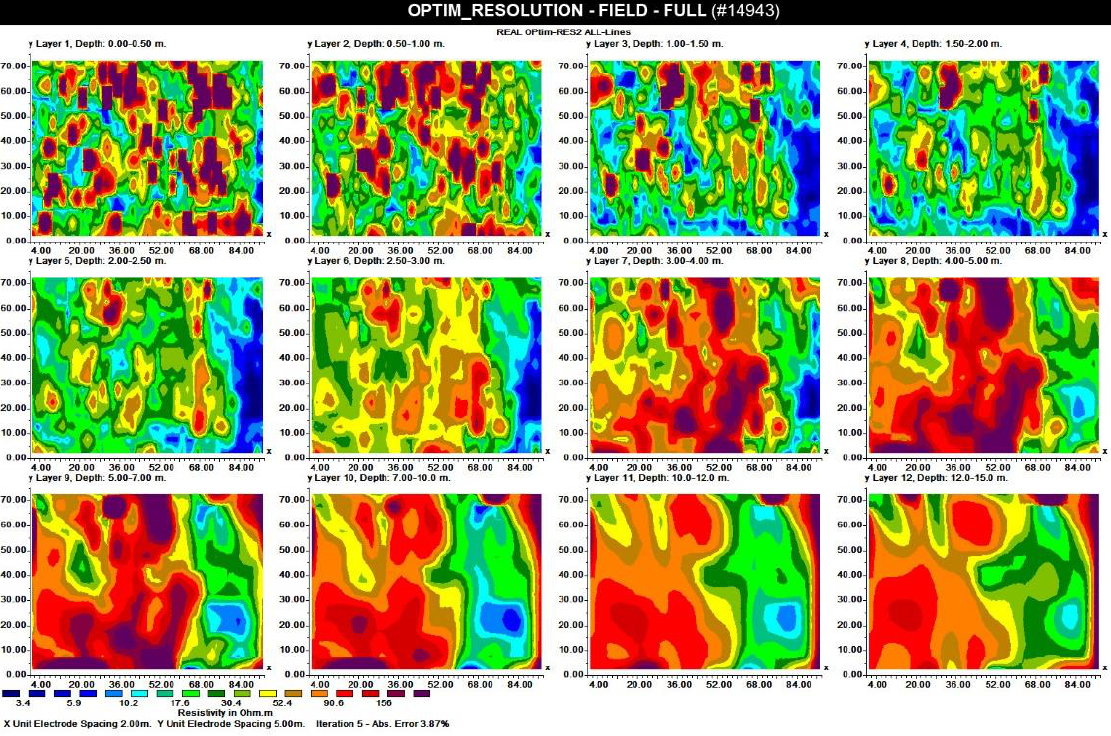
Figure 16. Inversion results from the Res-STUM field data set.